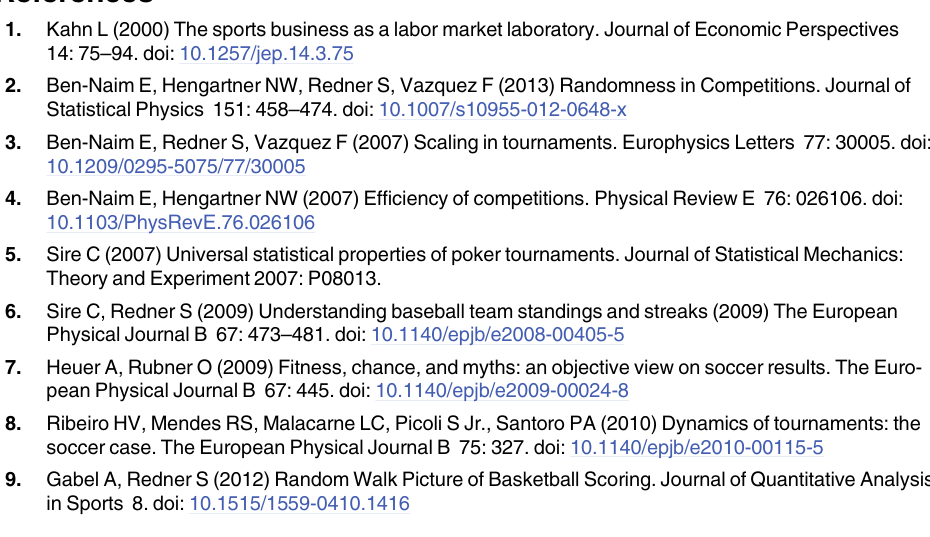
S4 Fig. Cumulative distributions of the time intervals between stores when the teams play home (red dots) and away (blue squares) for the second quarter of the games. The panels show the distributions in log-lin scale for each NBA season. The straight lines are guides for the eyes indicating the adjusted exponential behavior of these distributions. S5 Fig. Cumulative distributions of the time intervals between stores when the teams play home (red dots) and away (blue squares) for the third quarter of the games. The panels show the distributions in log-lin scale for each NBA season. The straight lines are guides for the eyes indicating the adjusted exponential behavior of these distributions. S6 Fig. Cumulative distributions of the time intervals between stores when the teams play home (red dots) and away (blue squares) for the fourth quarter of the games. The panels show the distributions in log-lin scale for each NBA season. The straight lines are guides for the eyes indicating the adjusted exponential behavior of these distributions. S7 Fig. Cumulative distributions of the time intervals between stores when the teams play home (red dots) and away (blue squares) for each NBA team along the seasons 2004 – 05 to 2013 – 14. The dashed lines are guides for the eyes indicating the adjusted exponential behavior of these